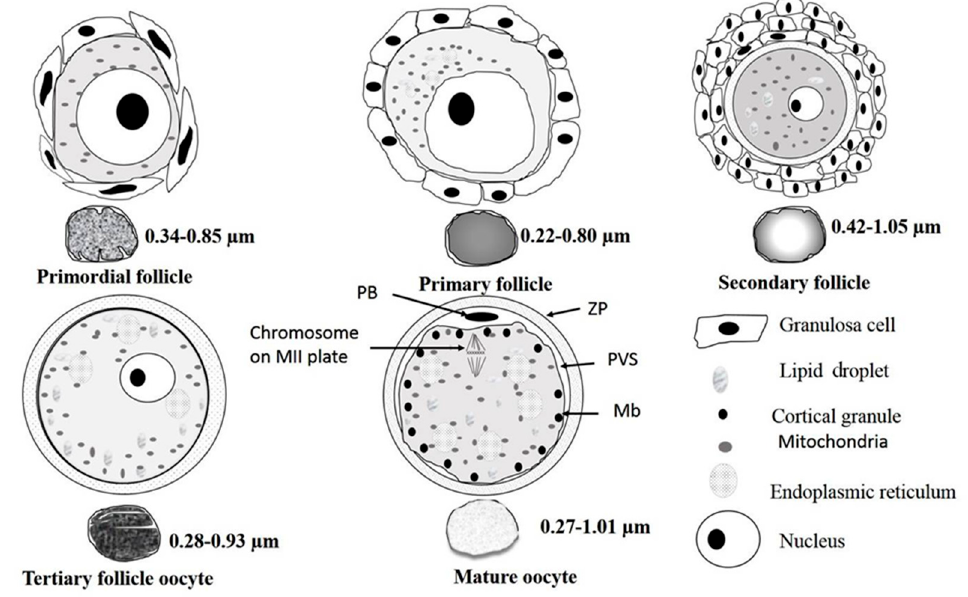
Figure 10. A summary diagram to illustrate mitochondrial morphodynamics in porcine oocytes during folliculogenesis toward meiotic maturation. Microtopography, size, shape, configuration of cristae, and matric density of the mitochondria change along the course of folliculogenesis. Oocyte mitochondria of the primordial follicle are roundish and the matrix is granite-like, and that of oocytes from primary follicles have darker matrices. The shape of mitochondria in the oocyte of secondary follicles is more elongated with vacuolated matrices. Oocytes of tertiary follicle also possess round mitochondria with elongated cristae and darker matrices. Mitochondria of in vitro matured oocytes have evenly distributed grayish matrices. Chronological and topomorphological changes of some major aggregates and organelle re-arrangement are observable during folliculogenesis and oocyte maturation. Table 1. Mitochondrion diameters ( µ m) of oocytes from various stages of folliculogenesis and after in vitro maturation.